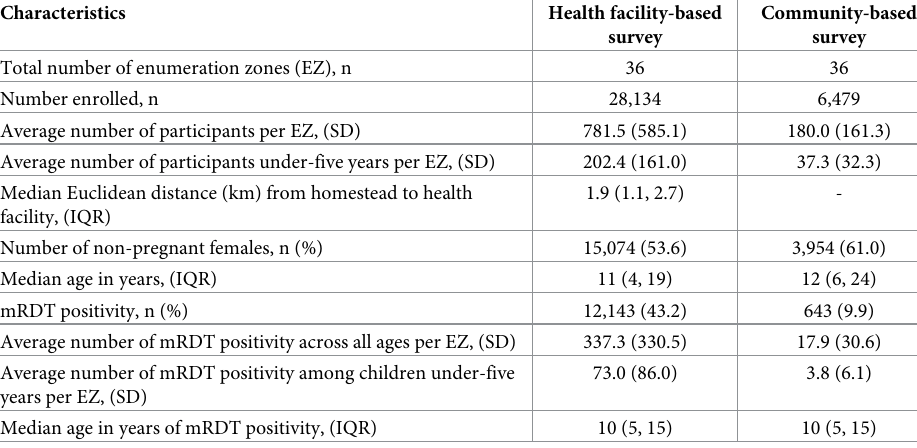
Table 1. Background characteristics of study participants in the health facility survey and community-based survey.